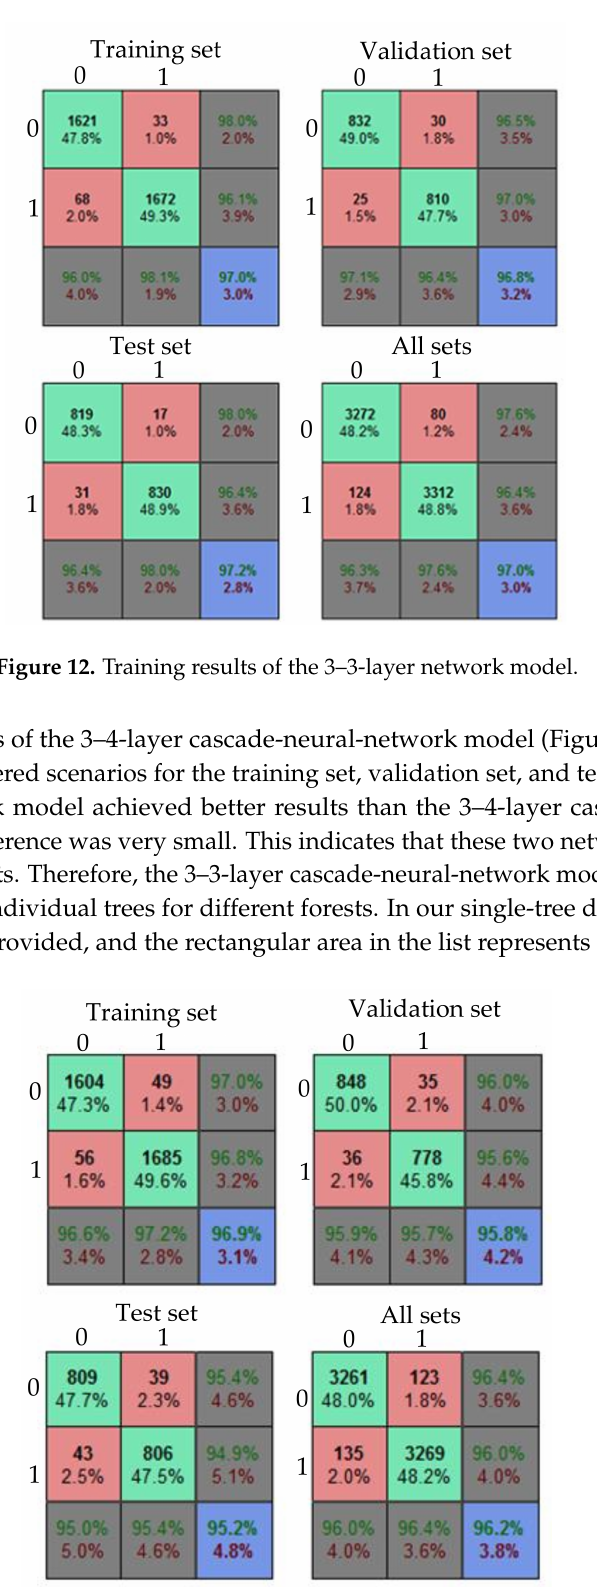
Figure 13. Training results of the 3–4-layer network